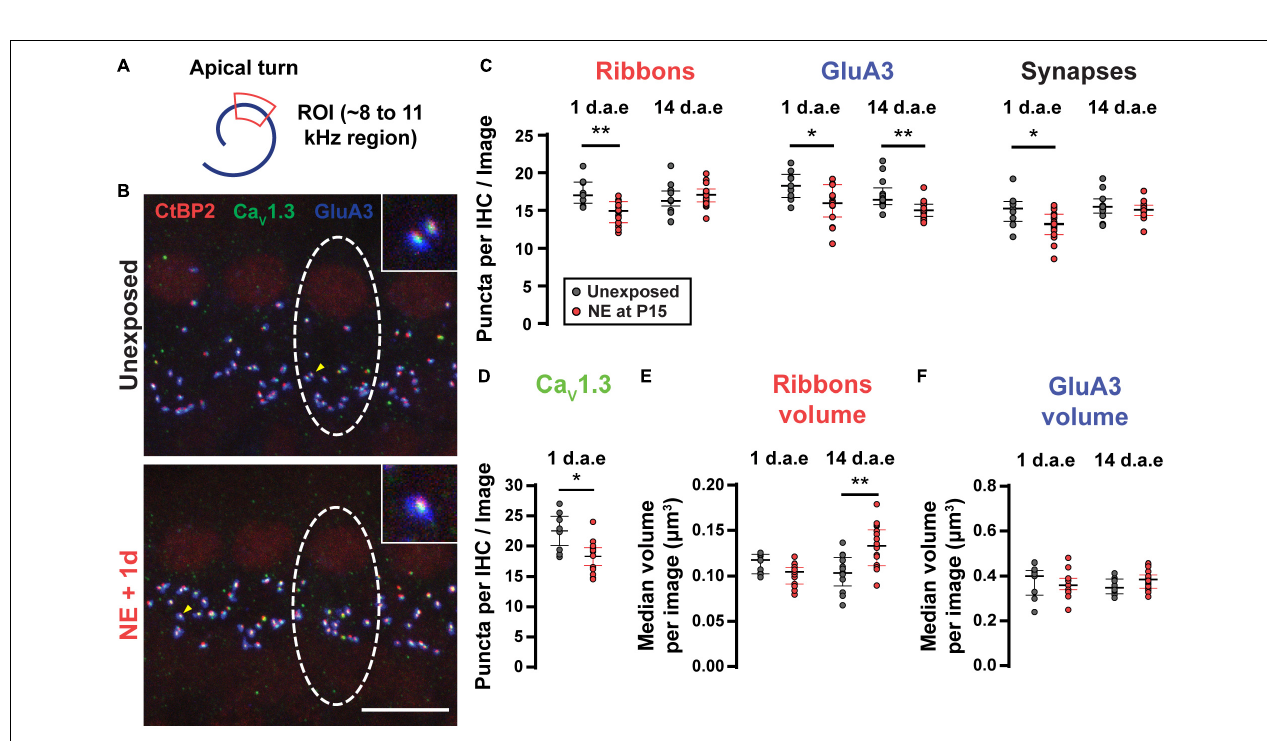
FIGURE 2 | A small reduction in the number of outer hair cells (OHCs) was detected after exposure to loud noise for apical and mid-cochlear regions. (A) Representative images of the OHC region of cochlear turns from control (Unexposed) and 14 d.a.e. mice with MyoVIIa immunostaining. Top and middle panels correspond to images obtained from the cochlear region that has a characteristic frequency of 11 kHz for Unexposed and 14 d.a.e., respectively. Picture in lower panel was collected from the 20 kHz region from a 14 d.a.e. mice. Scale bar: 10 µ m. (B) Percentage of OHC survival per z-stack for different cochlear segments. In the noise-exposed tissue there is a significant but small reduction in OHC survival for cochlear regions above 8 kHz. In all cases, median ± IQRs are shown, and the comparisons were made by Mann-Whitney unpaired test. * p < 0.05, ** p < 0.01.